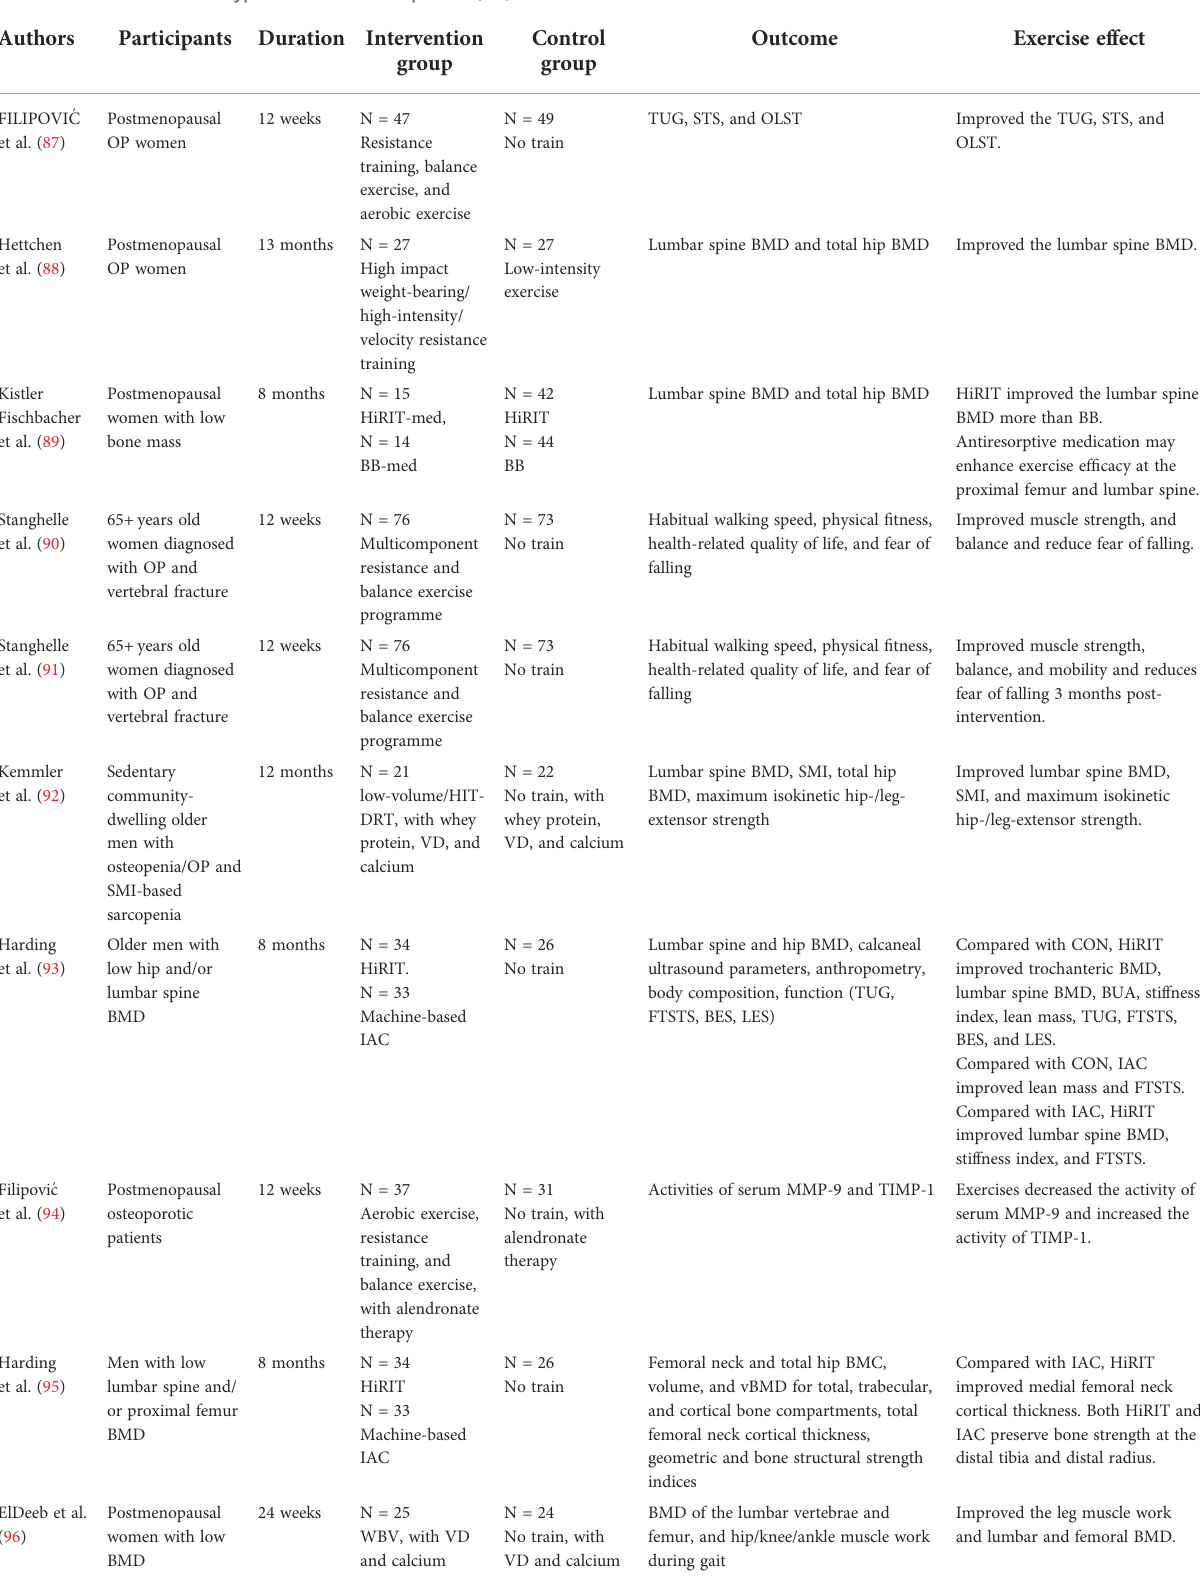
TABLE 2 Different exercise types on human osteoporosis